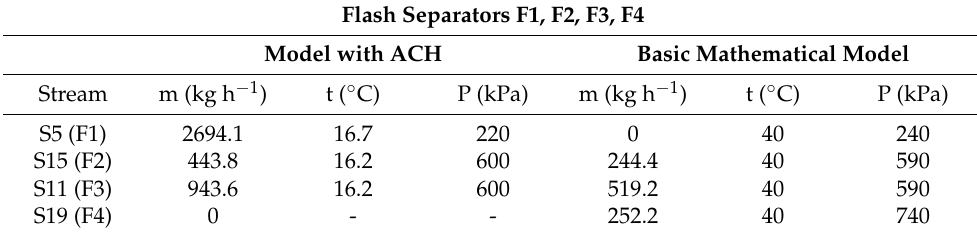
Table 8. Comparison of key parameters related to flash separators obtained by basic ASU model and by model comprising